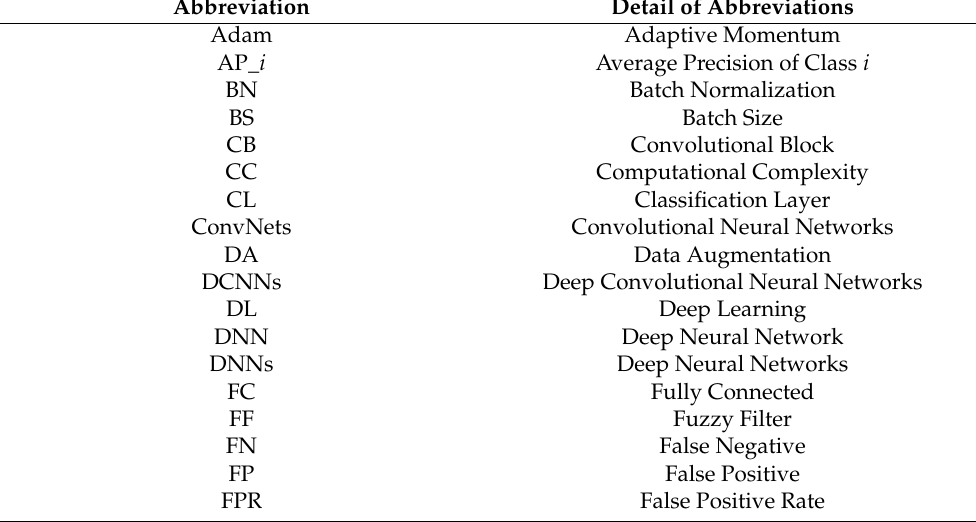
Table 1. Abbreviation guide